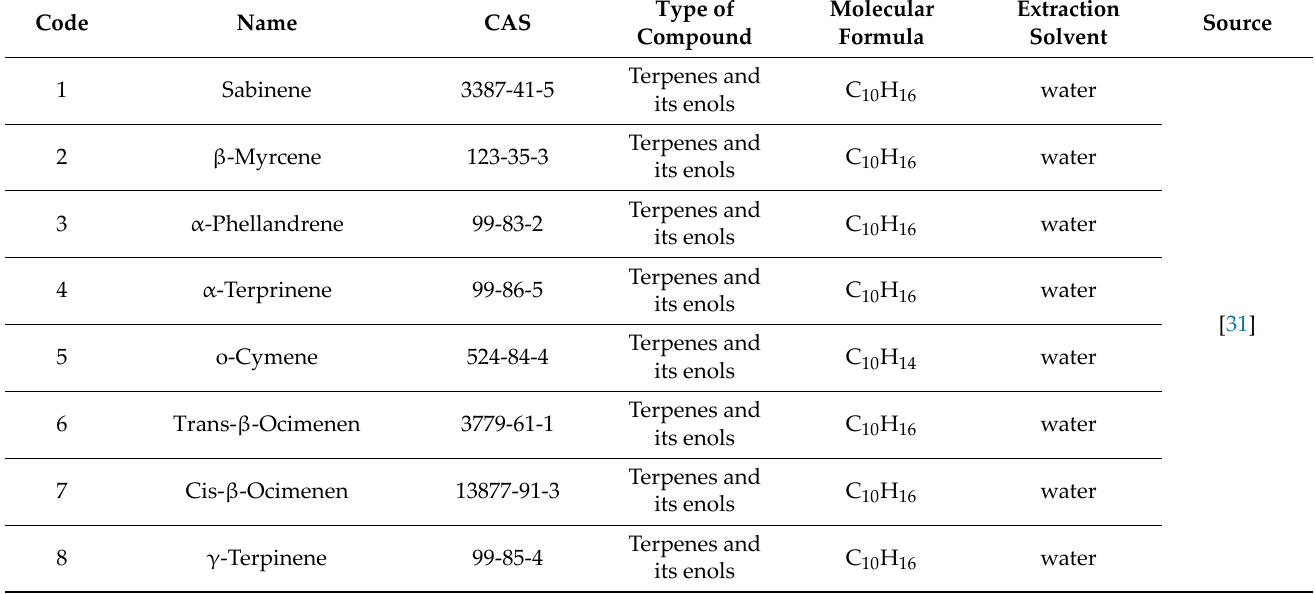
Table 3. Chemical components of